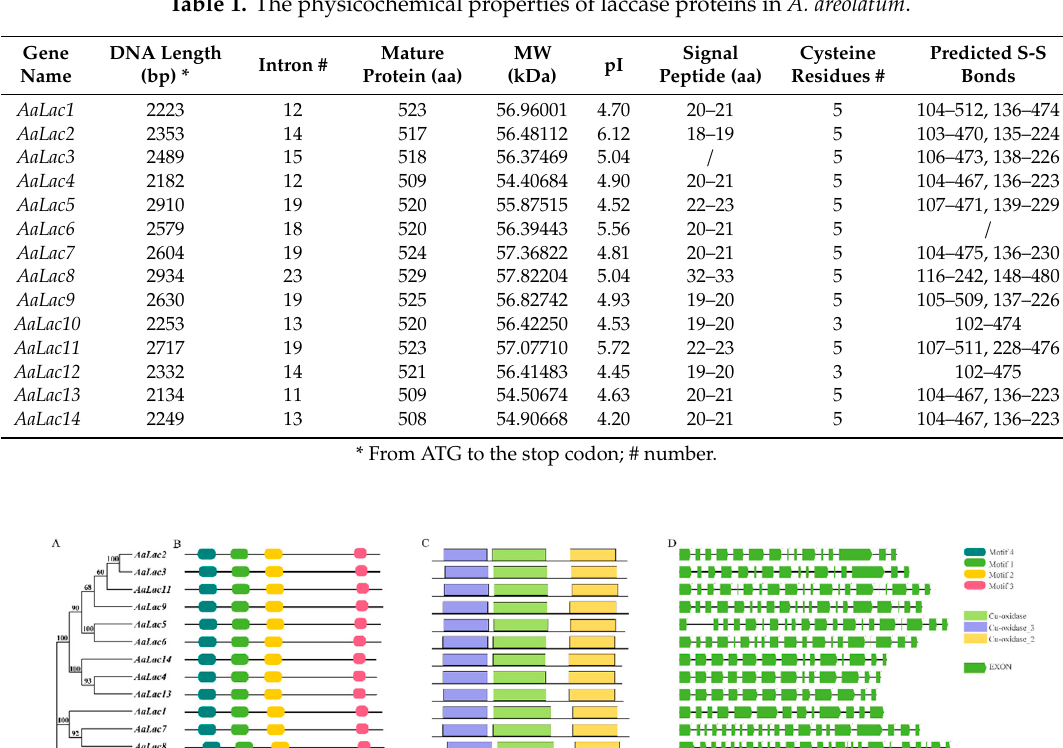
Table 1. The physicochemical properties of laccase proteins in A. areolatum .